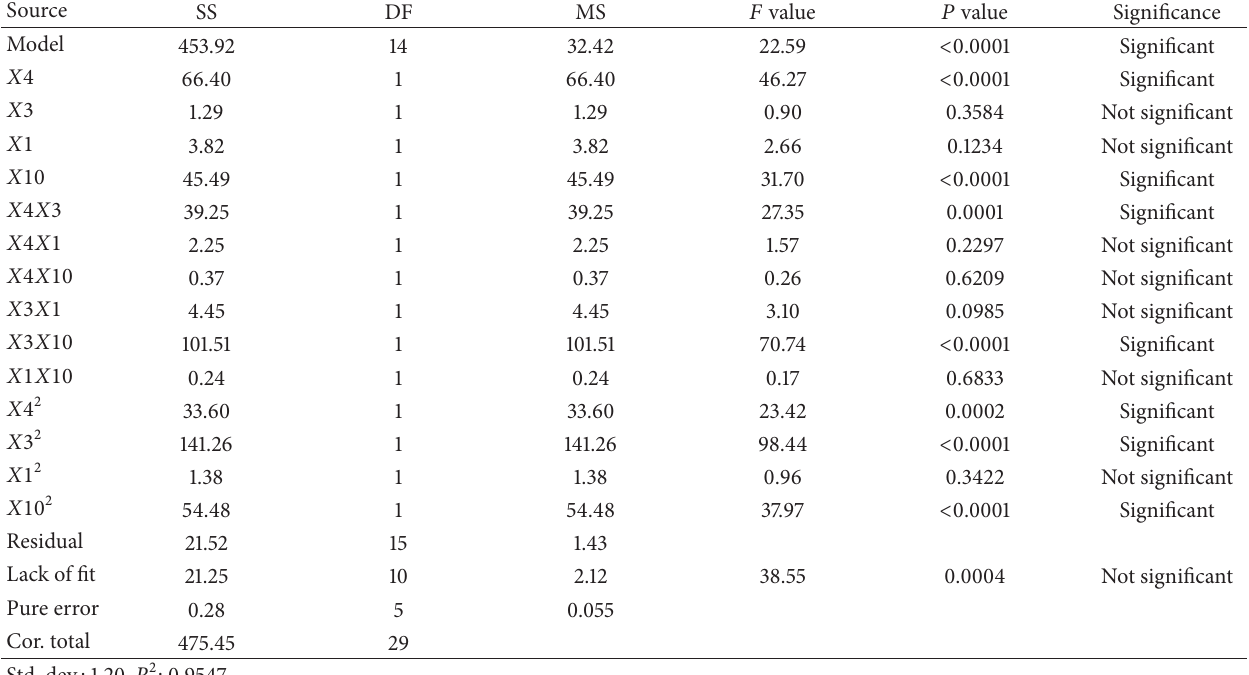
Table6:ANOVAforthefittedquadraticpolynomialmodelofrifamycinBproductionfrom mediterranei MTCC14byusingcentralcomposite design.